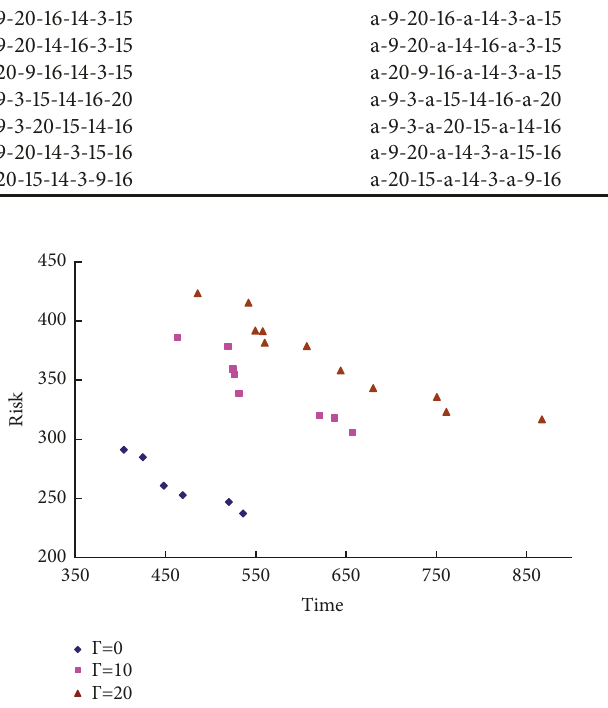
Figure 5: Pareto optimal solution distribution of robust control parameters Γ =0, Γ =10, and Γ =20 for distribution center b.